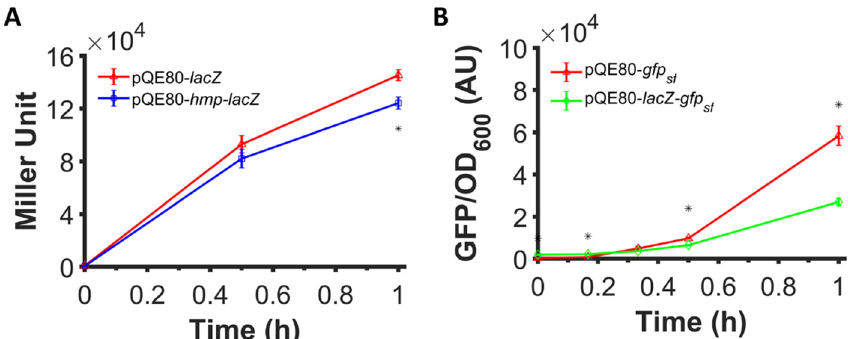
Figure 5. Fusion to Hmp did not boost the expression level of LacZ and fusion to LacZ did not boost the expression of sfGFP. ( A ) Shown are β -galactosidase activities of Δ lacZYA E. coli harboring pQE80-P T5 - lacZ (pXW11) and pQE80-P T5 - hmp-lacZ (pXW10) induced with 1 mM IPTG at time 0 after subtraction of the background signal (wild-type harboring pQE80L). ( B ) GFP fluorescence measurements normalized by OD 600 of wild-type E. coli harboring pQE80-P T5 - gfp sf (pXW09) and pQE80-P T5 - lacZ-gfp sf (pXW22) induced with 1 mM IPTG at time 0 after subtraction of the background signal (wild-type harboring pQE80L). Corresponding OD600 measurements and data of uninduced samples can be found in Figure S5. Data are the means of three independent replicates, and error bars represent the standard errors of the means. Asterisks (*) indicate statistically significant differences between samples as assessed using t-tests and a significance threshold of p -value ≤